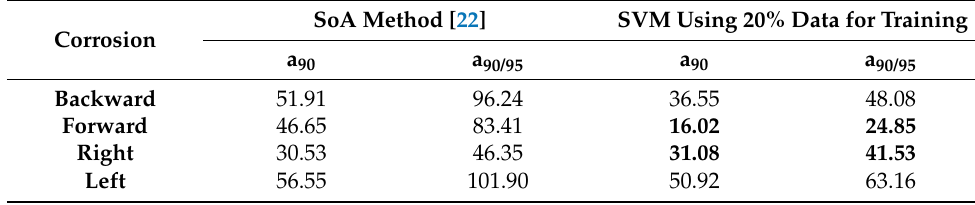
Table 4. Probability of detection